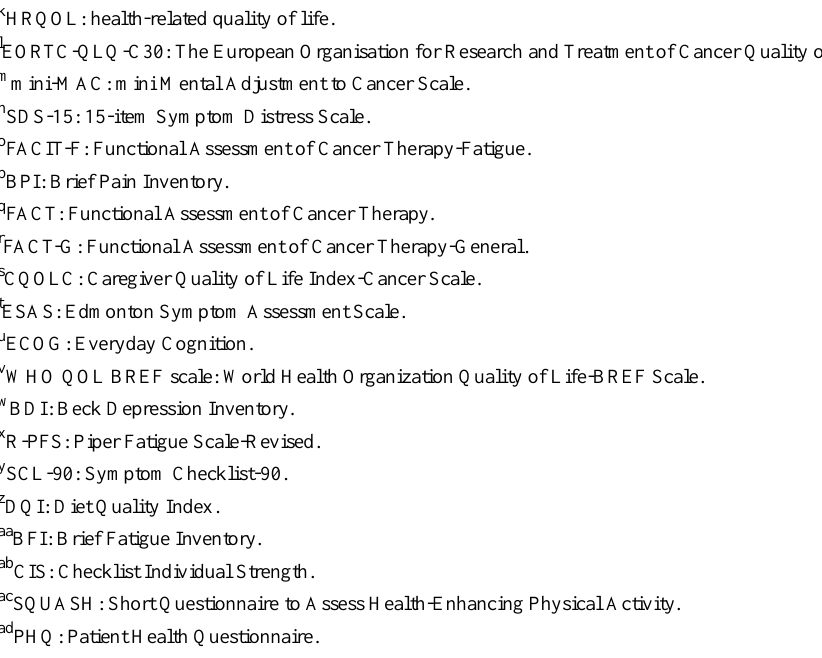
mini-MAC: mini Mental Adjustment to Cancer Scale.